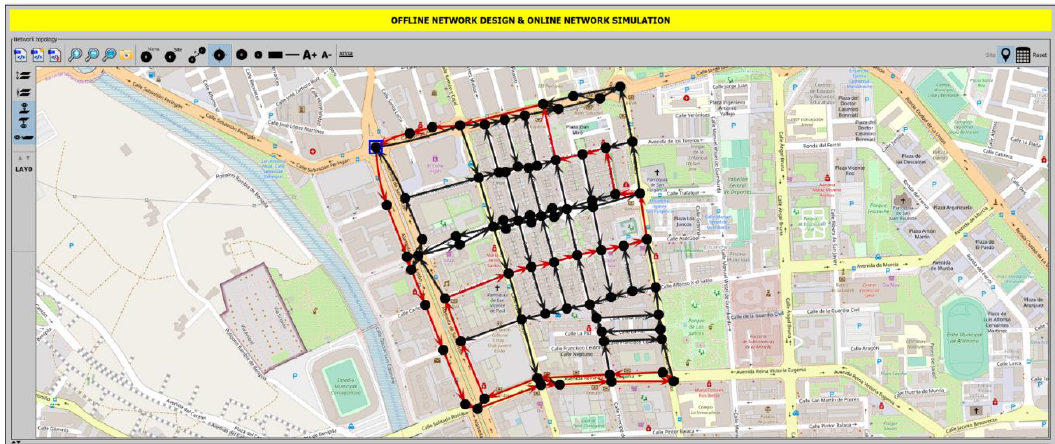
Figure 3. Snapshot of Net2Plan-GIS after integer linear programming (ILP) execution in the scenario under study in Cartagena city, setting threshold of waste level in containers to 85%. Optimal path route in red color.